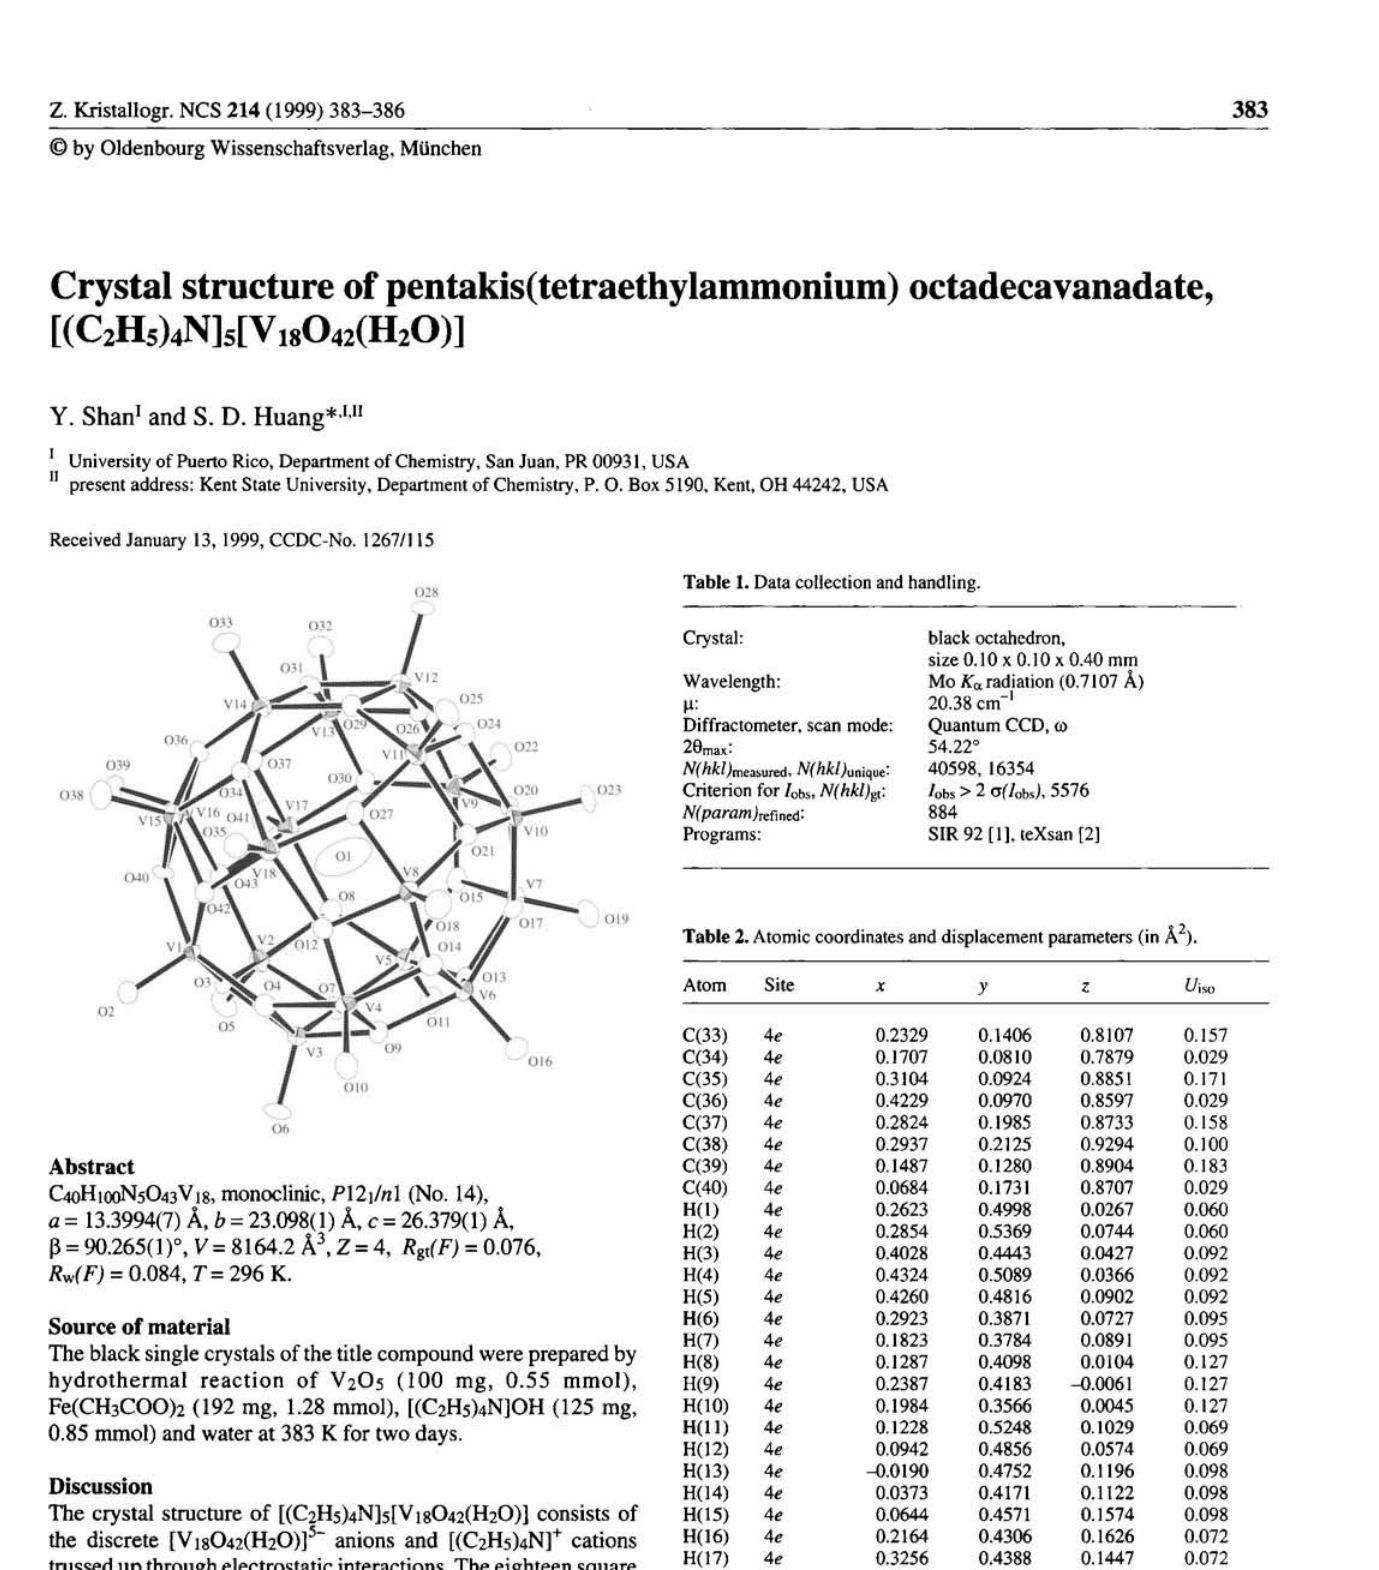
Table 2. Atomic coordinates and displacement parameters (in Â